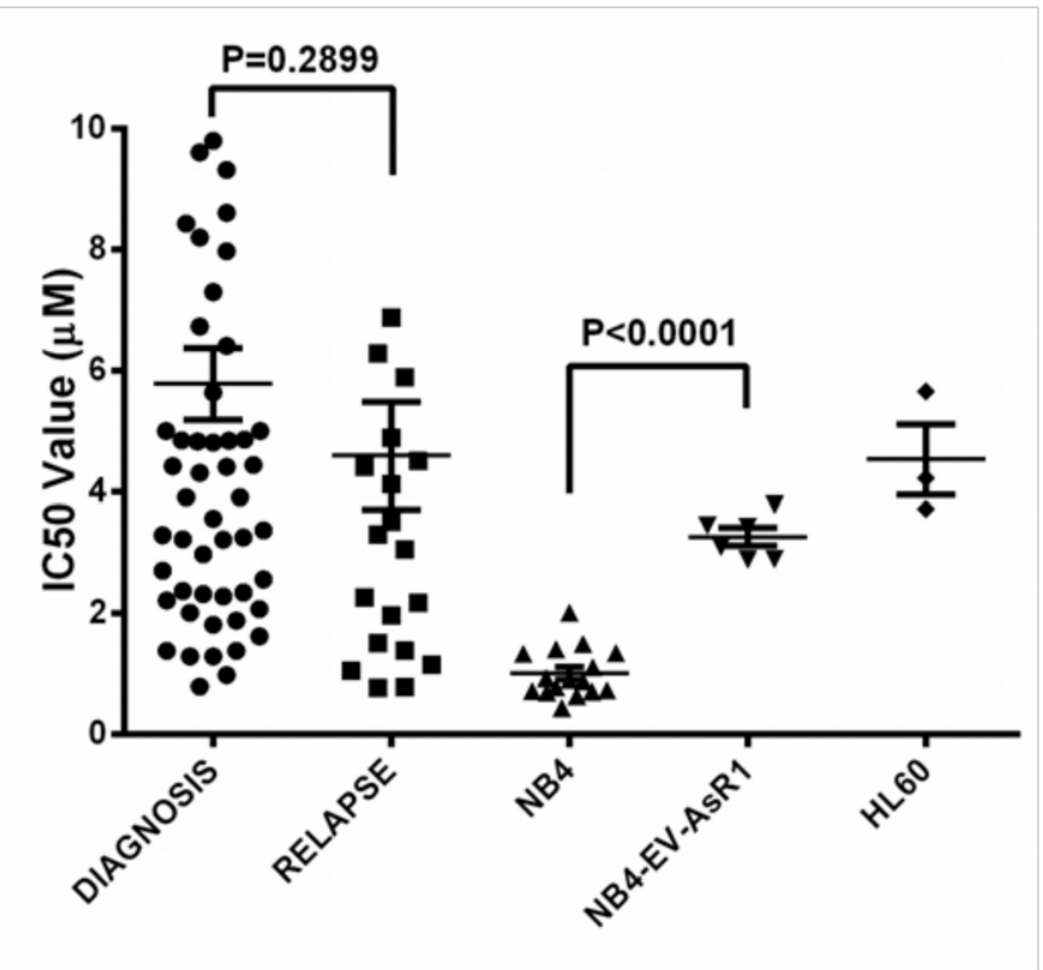
Fig 3. Comparison of in vitro cytotoxicity with ATO of NAPL Vs. RAPL and other cell lines. Scatter plots of the IC50 values of newly diagnosed patients (N = 61) and relapsed patients (N = 23) after treating with ATO concentrations ranging from 0.1 to 6 μ M for 48 hours is shown. The median IC50 of the newly diagnosed (4.41 μ M) and relapse group (3.51 μ M) was not significantly different and was higher when compared to that of NB4 cell line (N = 16). The median IC50 of NB4 was 0.9 μ M, while that of NB4-EV-AsR1 (ATO resistant NB4 cell line) was 3.25 μ M. The IC50 of HL60 was 4.25 μ